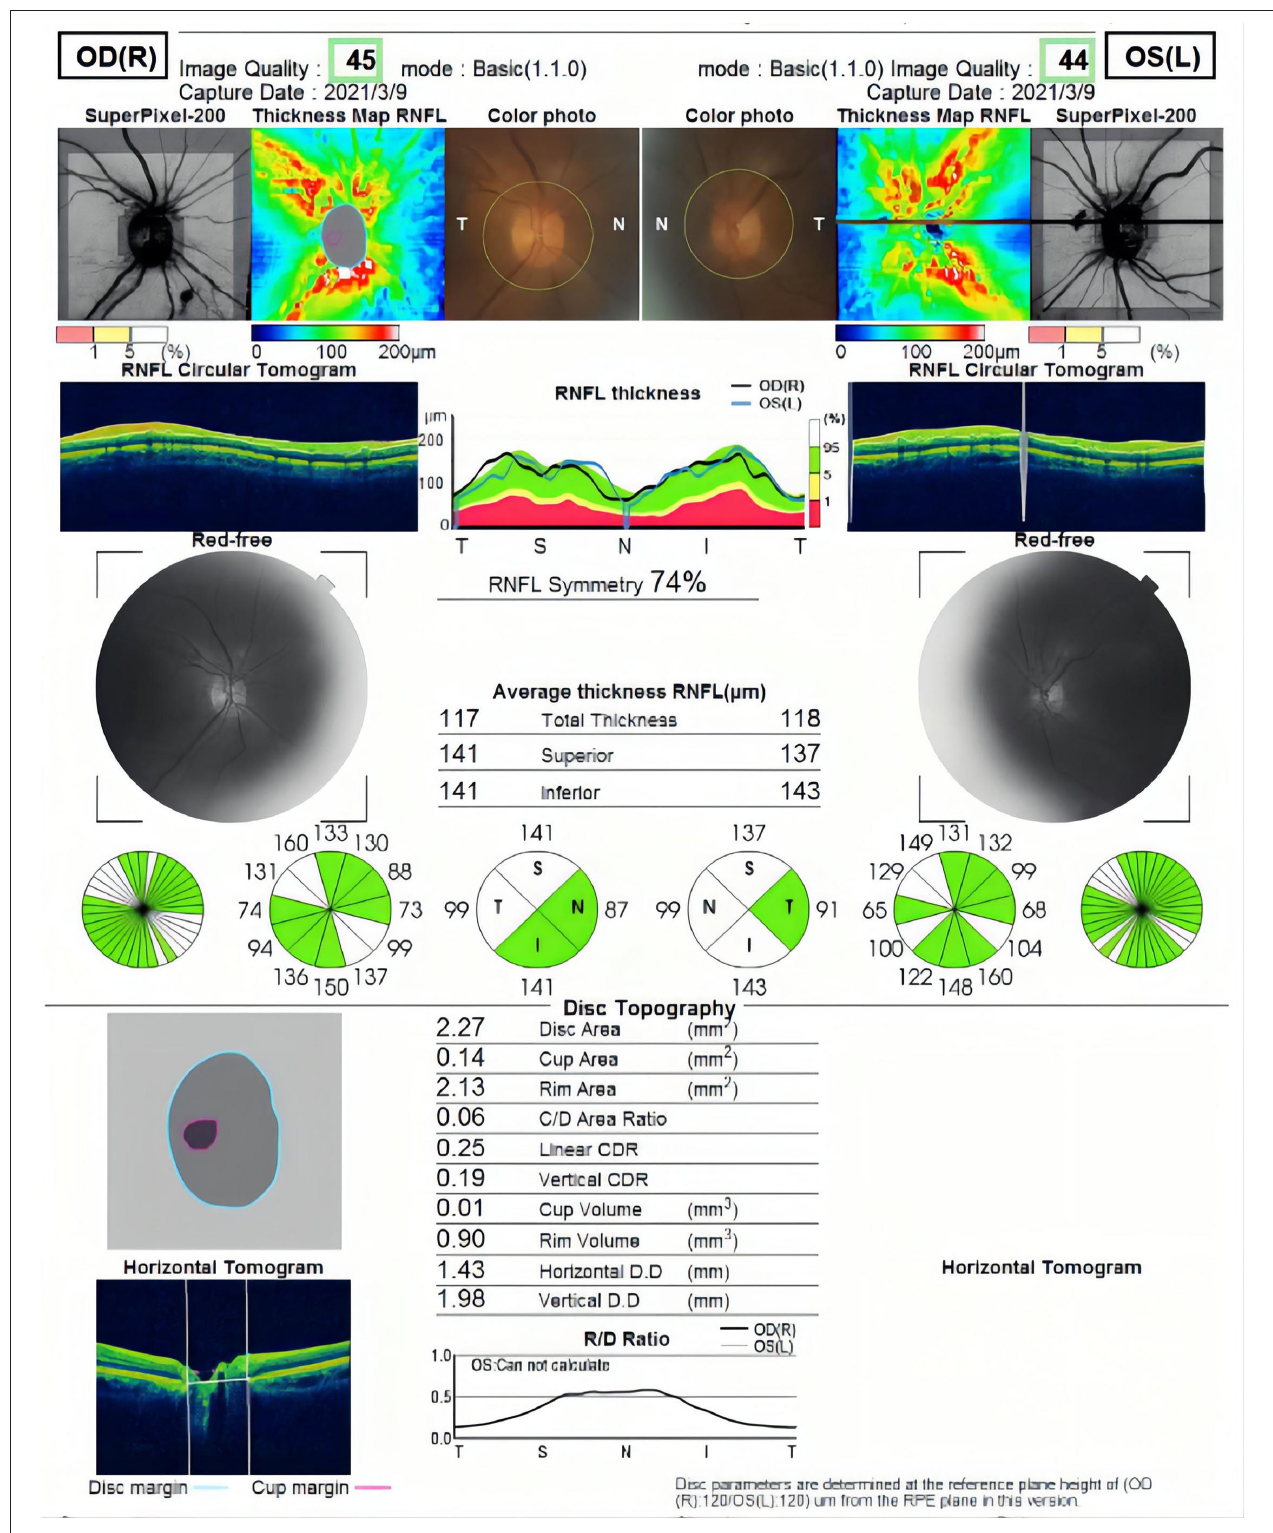
FIGURE 3 | The optical coherence tomography (OCT) examination of retinal nerve fiber layer (RNFL) thickness in the optic disc.